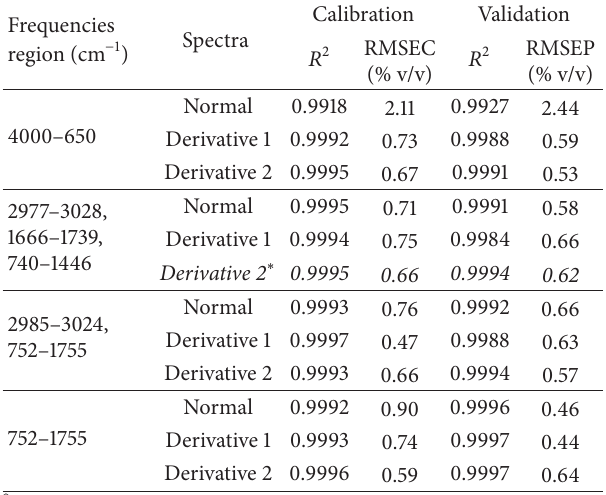
Table 3: PLS performances at some frequency regions for the determination of NSO in binary mixtures with CO.